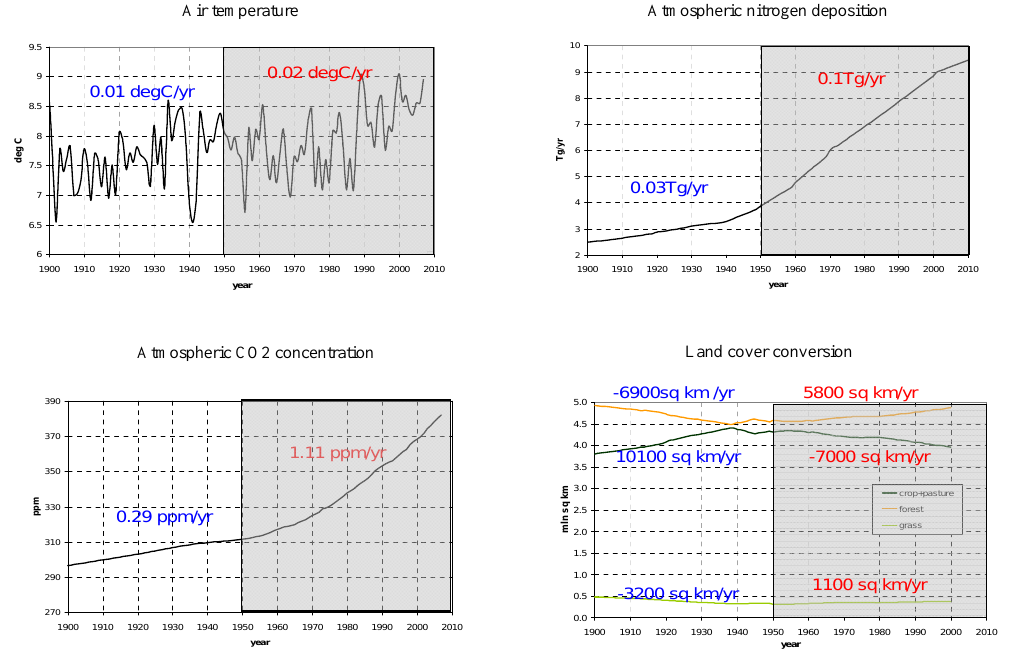
Fig. 1. Changes in major environmental drivers of carbon balance of Europe over 20th century. Annual values of average air temperature, atmospheric nitrogen deposition, and land cover conversion are calculated for the whole study domain. Atmospheric CO 2 concentrations are calculated as global